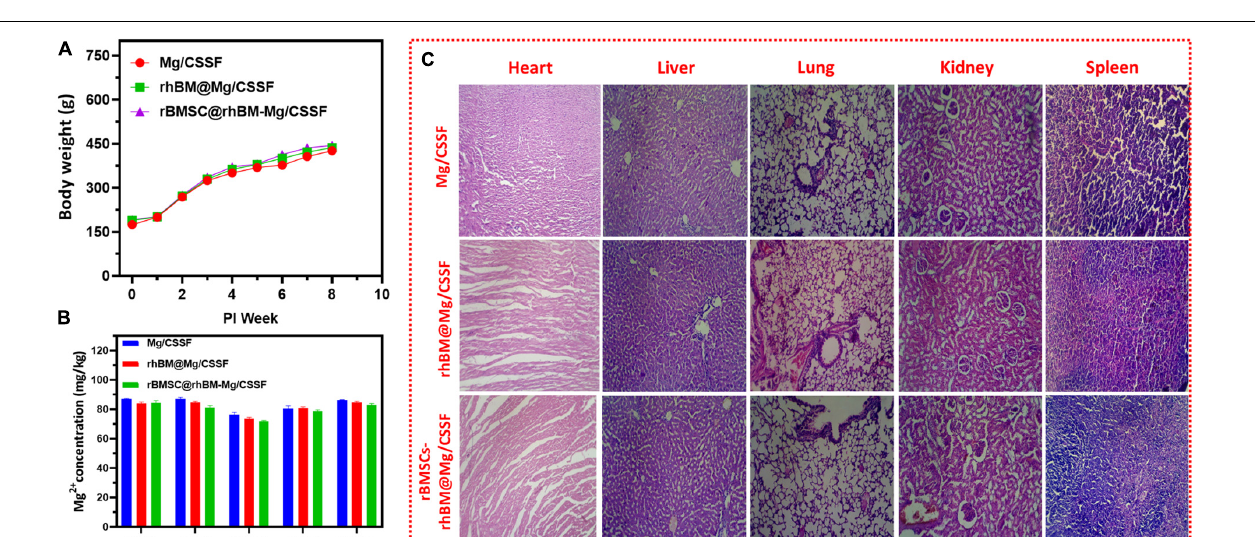
FIGURE 9 | Histological sections of treated femoral defect models implanted with injectable hydrogel groups were observed by using hematoxylin and eosin (H&E) (A) and Masson’s trichrome (MTS) stains (B) . The histological microscopic observations were observed in two magnifications (10 × and 40 × ) to show bone remodeling and regeneration.